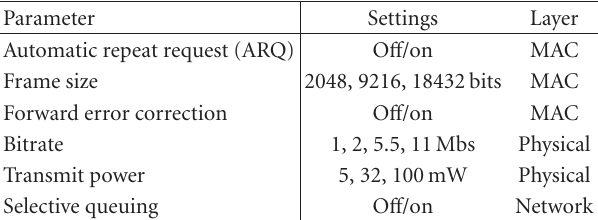
Table 2: The set of mutable parameters.